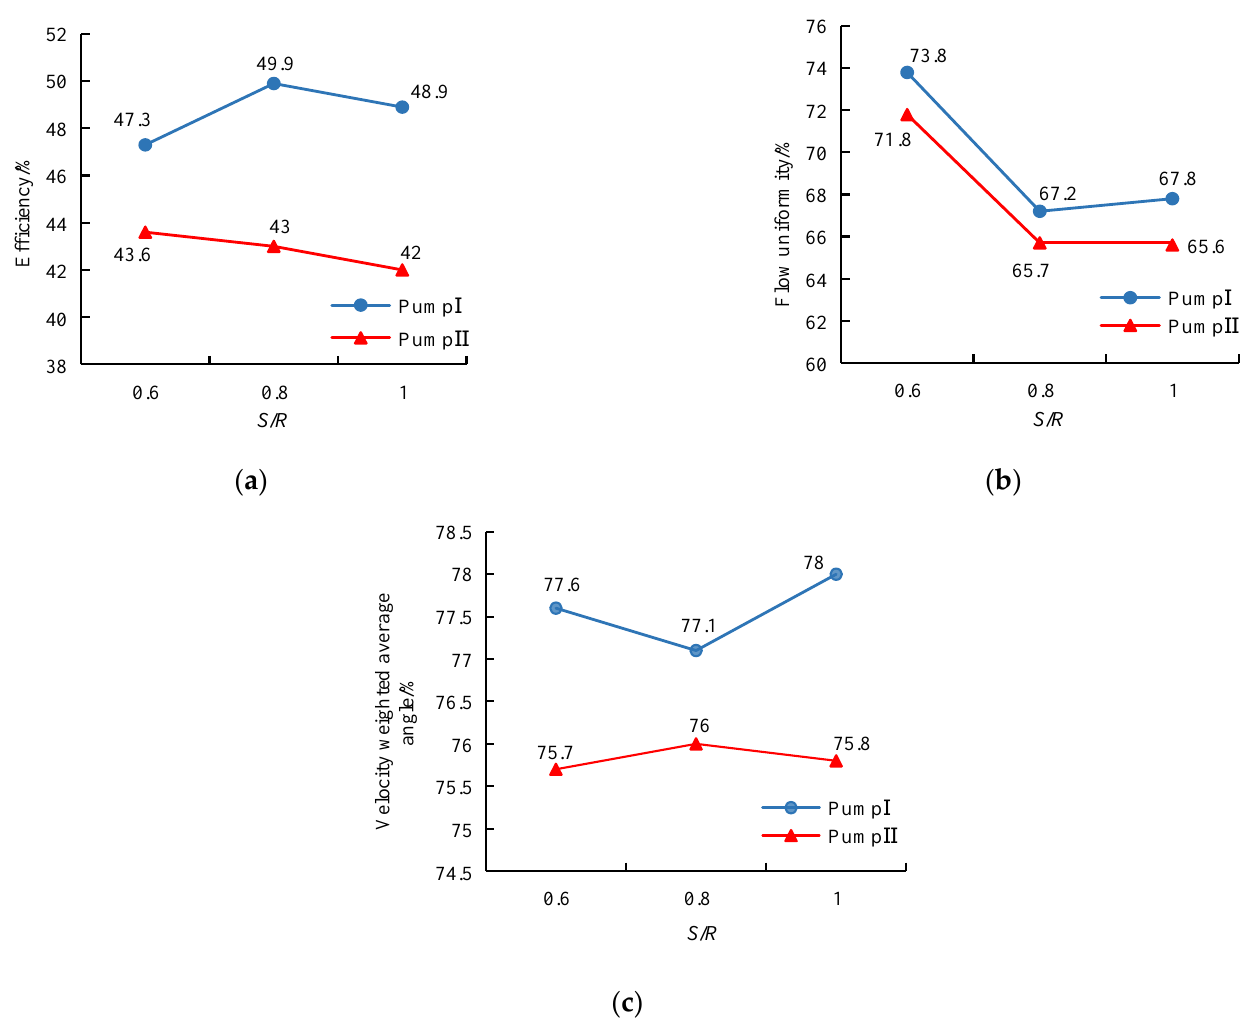
Figure 9. ( a ) The influence of S on the efficiency of the two pumps; ( b ) Variation of the inlet velocity uniformity of the pump impeller chamber with S ; ( c ) The weighted average angle of the inlet velocity of the pump impeller chamber with S.